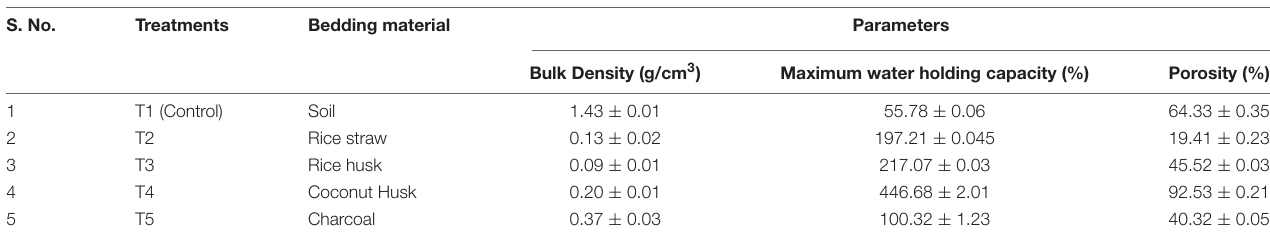
TABLE 2 | Physical characteristics of FBM used in the study. S.